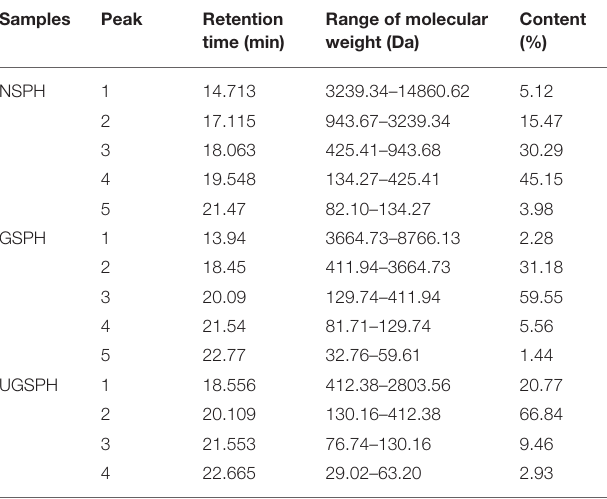
TABLE 3 | Molecular weight of several soybean protein hydrolysates.